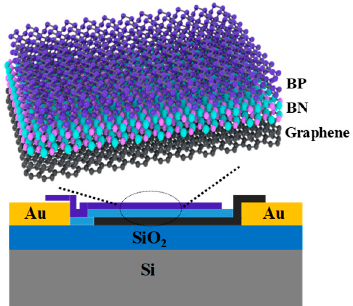
Figure 1. Schematic of the black phosphorus (BP)/boron nitride (h-BN)/graphene van der Waals heterojunction. The few-layer BP flake was transferred onto the few-layer graphene flake and the two were separated with boron nitride, forming a vertically-stacked heterojunction.